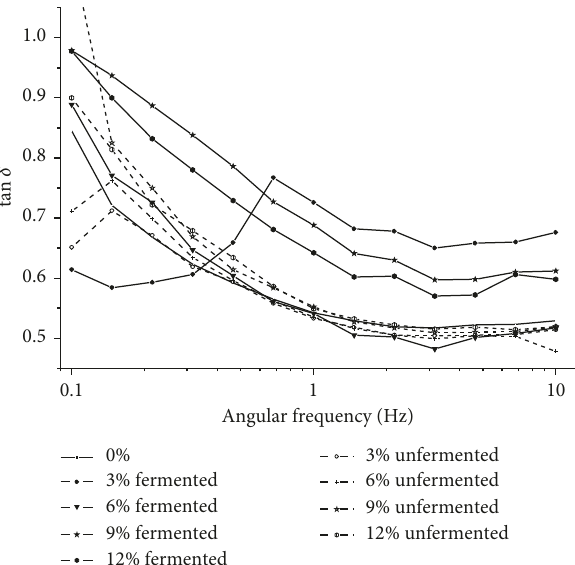
and G of Figure 4: The effect of fermented and unfermented bran addition ′ ″ on the tan δ of bread dough.